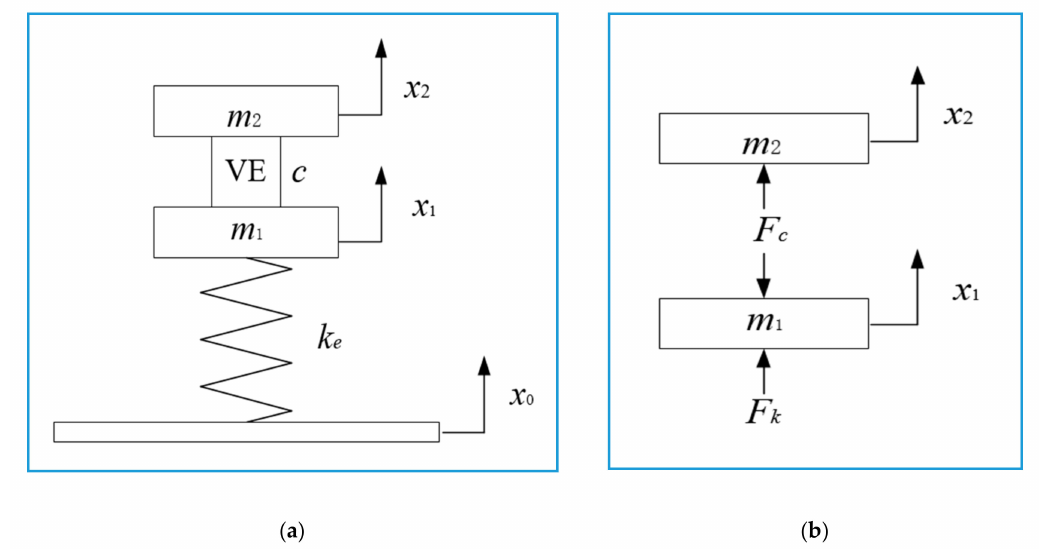
Figure 14. Two-degree-of-freedom model of suspension